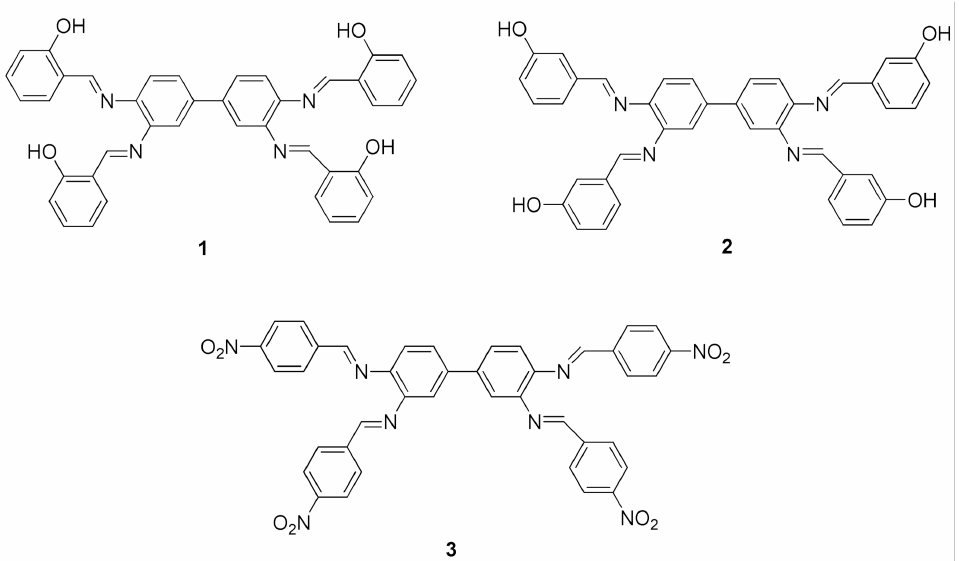
Figure 1. Tetra Schiff bases 1 – 3